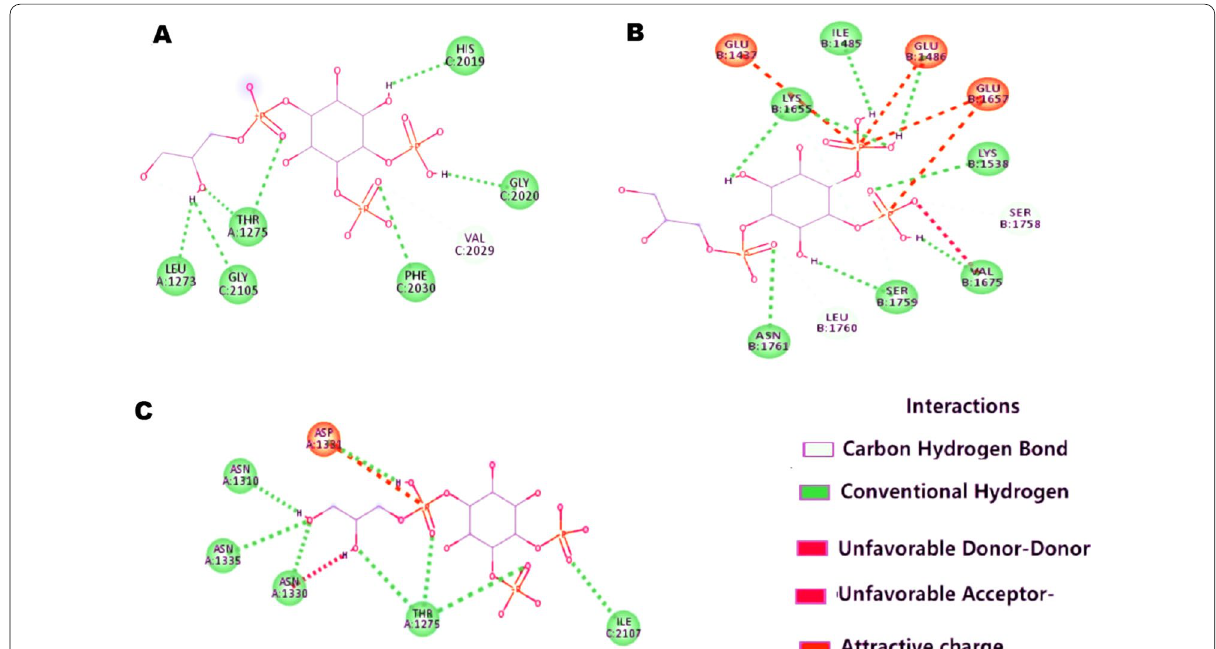
Fig. 8 Auto Dock Vina results analysis of wild and mutated structures: The ligand (PIP 2 ) appeared in the center of the structure(as sticks) surrounded by the adjacent protein residues in the docking pocket appeared in green circles where A wild type docing result B mutant R1230H docking results C mutant E1393K docking result